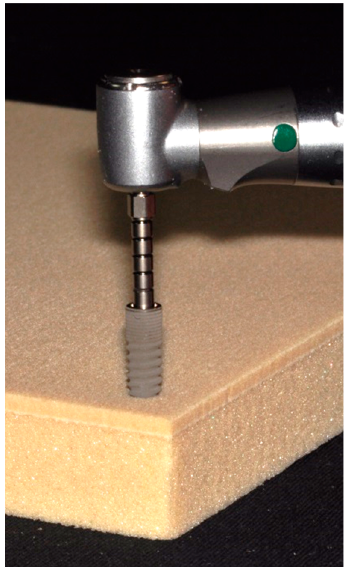
Figure 2. Implants were inserted in laminated polyurethane foam material using a surgical motor capable of recording the actual torque applied over time.